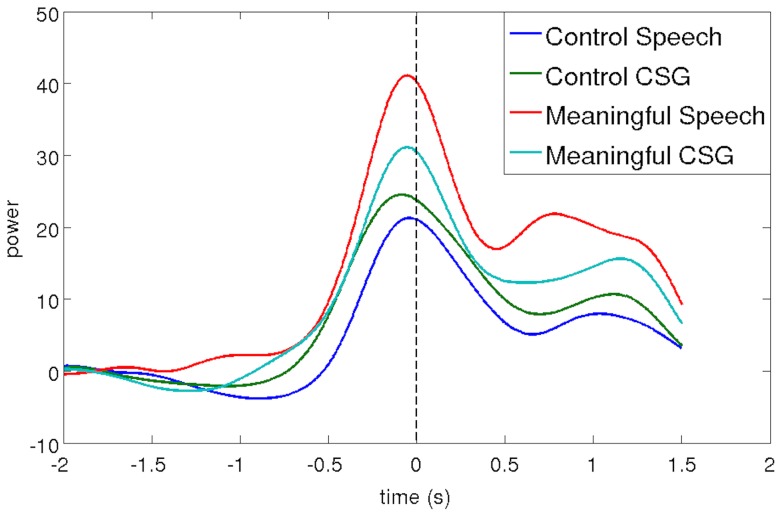
Smoothed power envelopes of high gamma responses extracted from left medial temporal lobe using beamforming.The different curves show a similar pattern for speech and CSG in control trials but a different pattern for speech and CSG in meaningful trials.